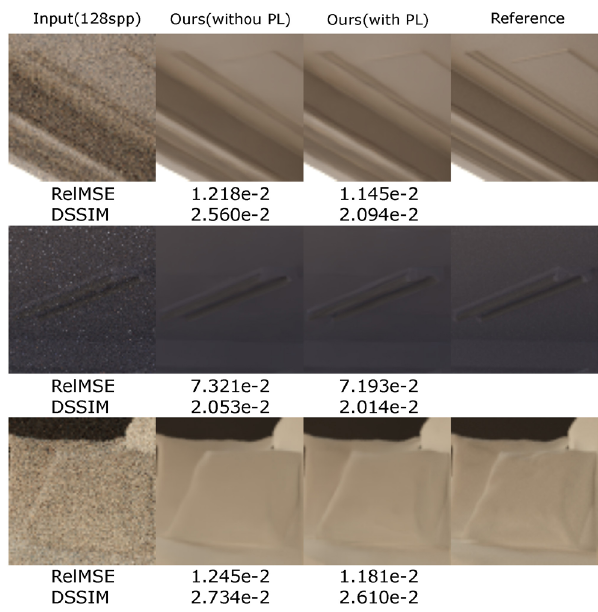
Fig. 13 Comparison of our method with and without separation (sep.) of color and auxiliary features.